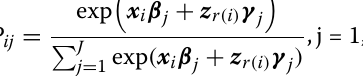
Data source: NEPS, SC4